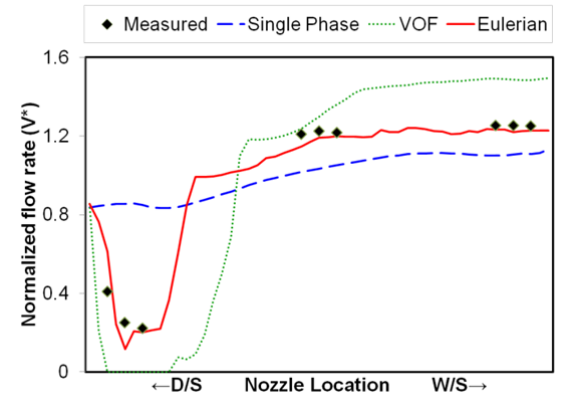
Figure 4. Comparison between the experimental and the numerical results.